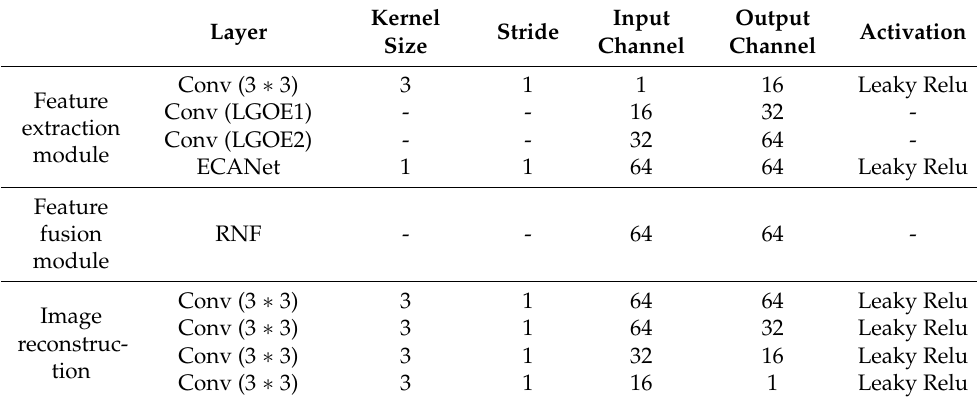
Figure 1. The overall framework of the proposed method. Table 1. Detailed architecture diagram of the method proposed in this paper.